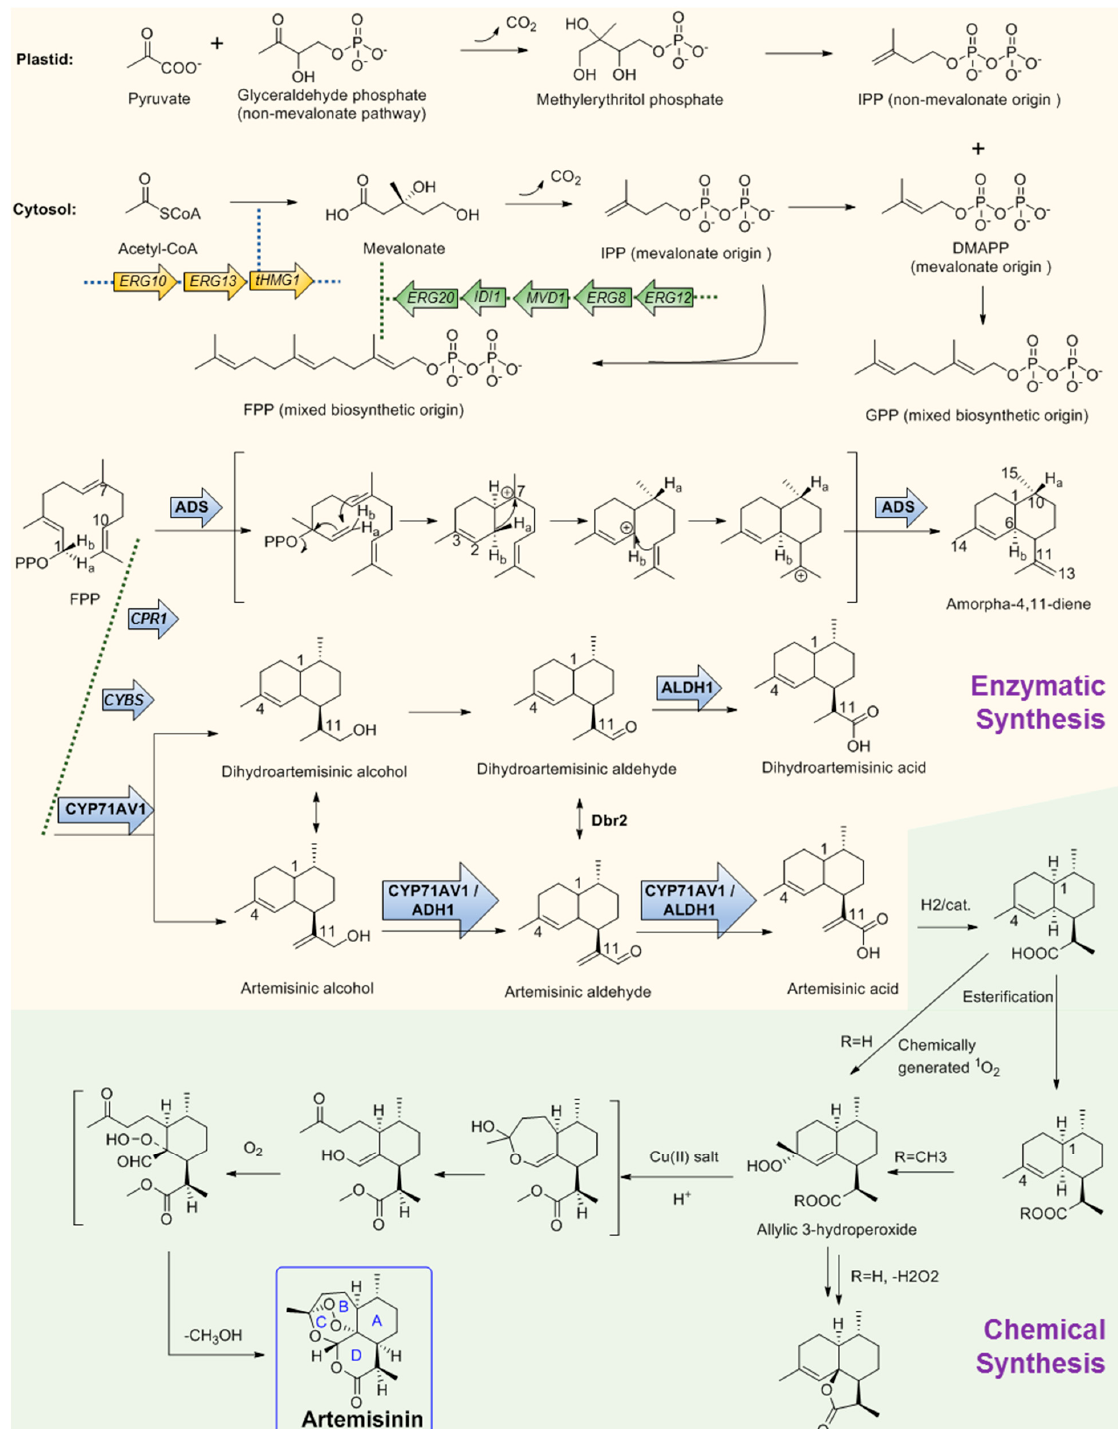
Figure 2. Chemo-enzymatic synthesis of artemisinin. Yellow region shows the biosynthesis pathways for artemisinic acid production. Green region shows the chemical conversion route of artemisinic acid to artemisinin. tHMGR, 3-hydroxy-3-methylglutaryl-coenzyme A reductase; ADS, amorphadiene synthase; CYP71AV1, amorpha-4; 11-diene monooxygenase; ADH1, artemisinic alcohol dehydrogenase; ALDH1, artemisinic aldehyde dehydrogenase 1; Dbr2, artemisinic aldehyde Δ 11 (13) reductase; CPR1, cognate reductase of CYP71AV1. Arrows with frames showed the gene elements manipulated by Keasling’s team for artemisinic acid production engineering strain